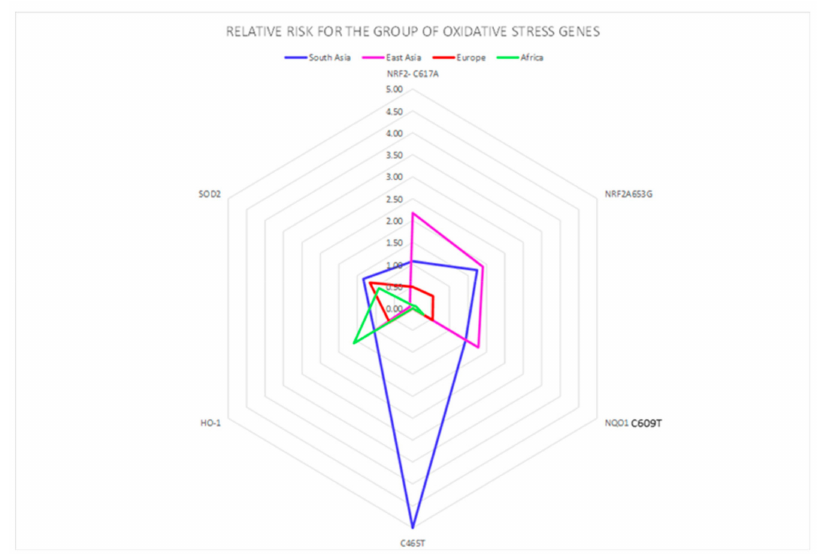
Figure 2. Oxidative stress polymorphic genes are highlighted with di ff erent colors in the four ethnic groups. The genes are represented by geometrical figures, where the tip of the figure points toward the most susceptible genes belonging to each gene group.